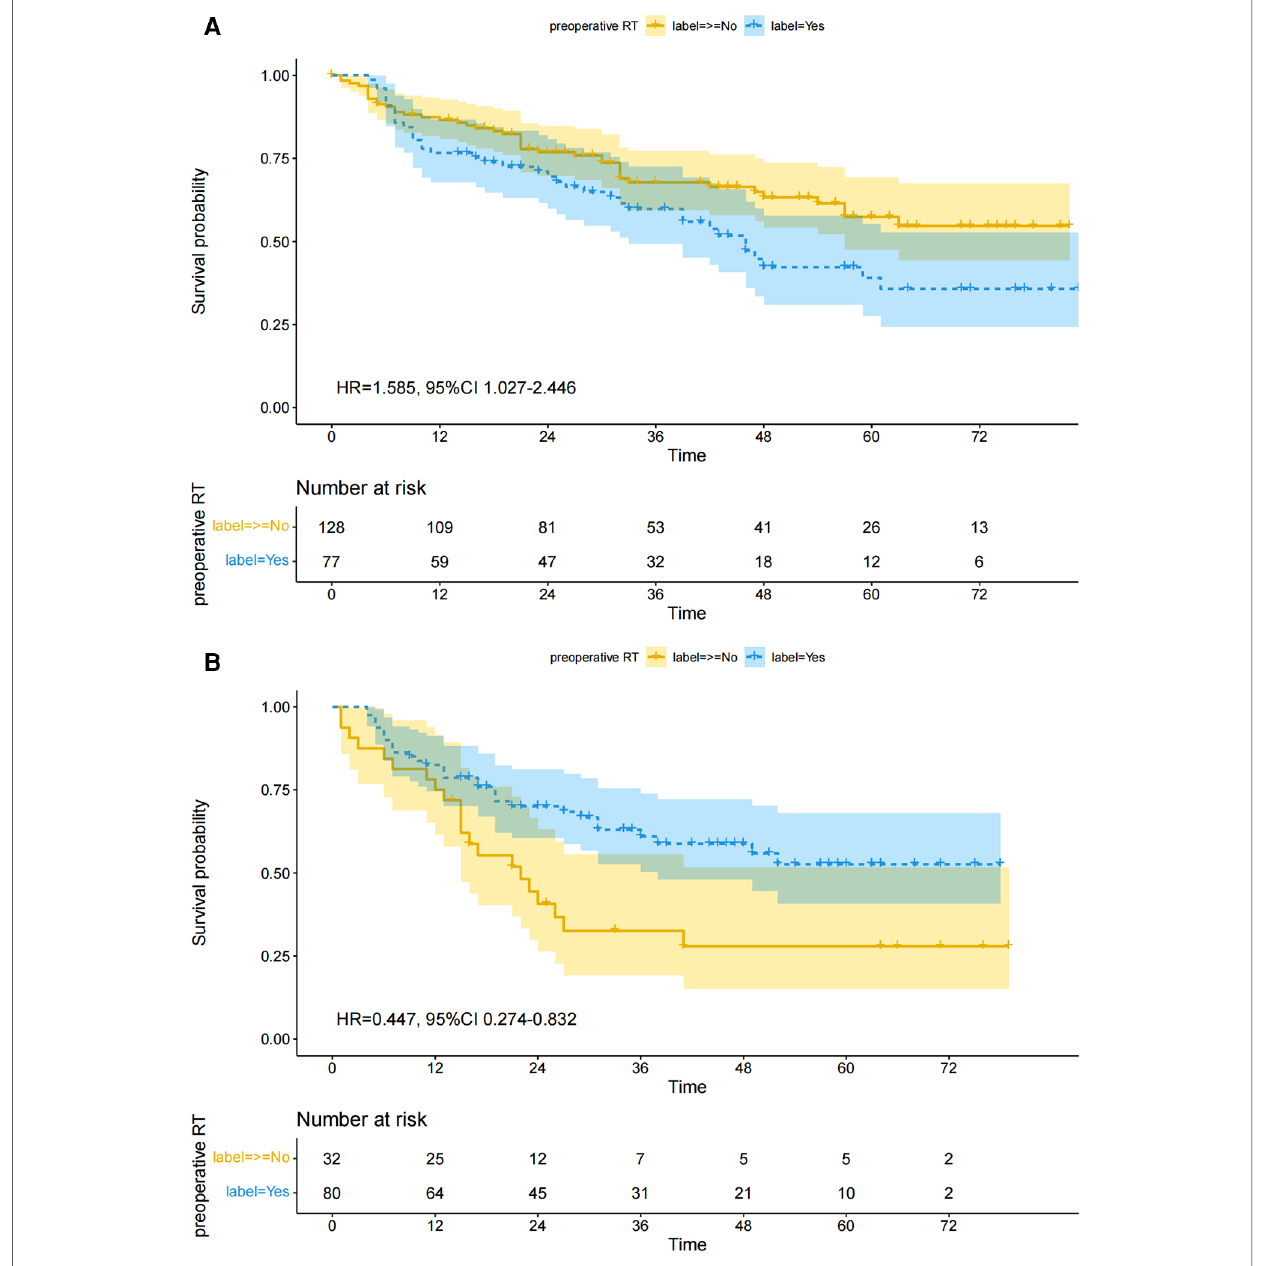
FIGURE 2 Overall survival between preoperative RT and non-preoperative RT groups after matching. ( A ) cT1 – 2, ( B ) cT3 –